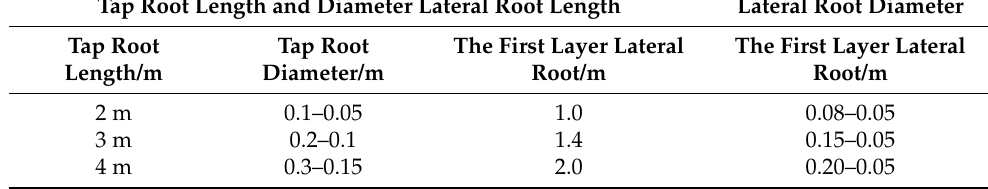
Table 1. Parameters of tap roots and lateral roots.